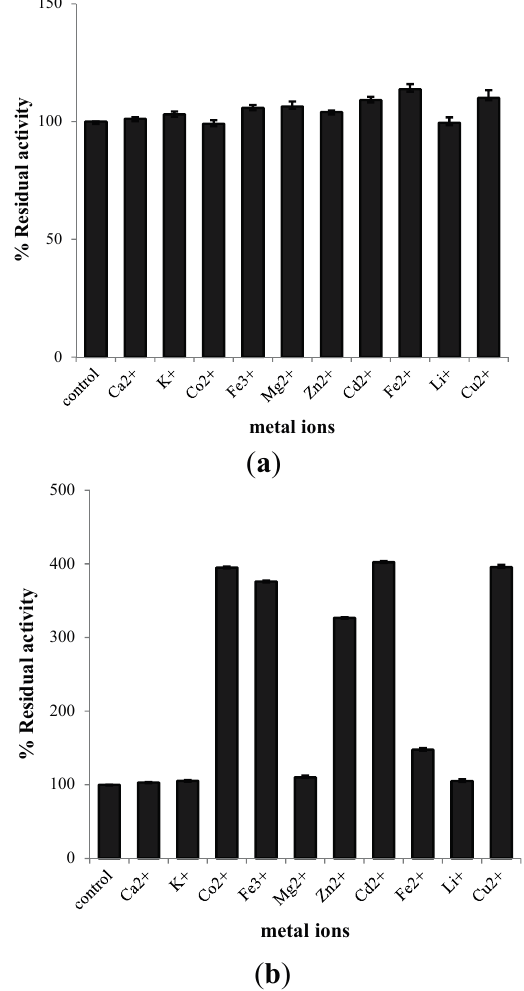
Figure 5. ( a ) Effect of 10 mM metal ions on chitinolytic activity of EcChi1; ( b ) Effect of 10 mM metal ions on chitinolytic activity of EcChi1 after incubated with EcChi1 for 20